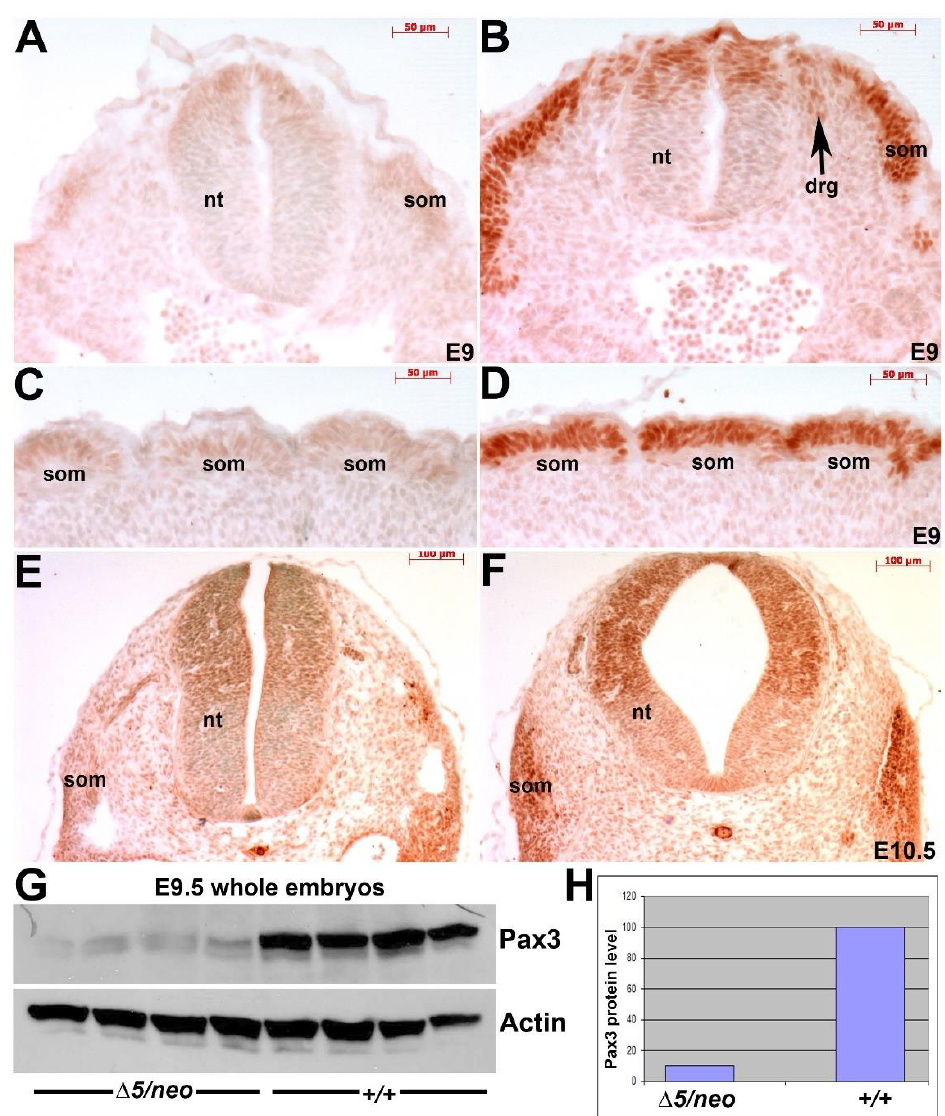
Figure 2. Pax3 protein expression is globally reduced ~90% in Pax3 ∆ 5/neo hypomorphic mutants. ( A – D ) IHC reveals reduced Pax3 protein levels in E9.5 Pax3 ∆ 5/neo mutants ( A , C ) compared to robust expression in age-matched littermate control embryo ( B , D ) within the dorsal neural tube (nt), dorsal root ganglia (DRG) and somites (som). Moreover, Pax3 protein is suppressed in both anterior ( A , B ) and caudal ( C , D ) somites. ( E , F ) Pax3 protein levels remain reduced throughout the entire E10.5 Pax3 ∆ 5/neo mutant embryo ( E ) compared to wildtype littermates ( F ). ( G , H ) Western analysis of Pax3 in E9.5 whole embryo lysates ( n = 4 individuals of each genotype) revealed a significant reduction in full- length Pax3 levels, as band size identical to wildtype. Pax3 level were determined by densitometry and normalized to Actin expression ( H ). Relative to 100% expression in wildtype, there is only 10% Pax3 within the Pax3 ∆ 5/neo mutants. Scale ( A – D ), 50 µ m; ( E , F ), 100 µ